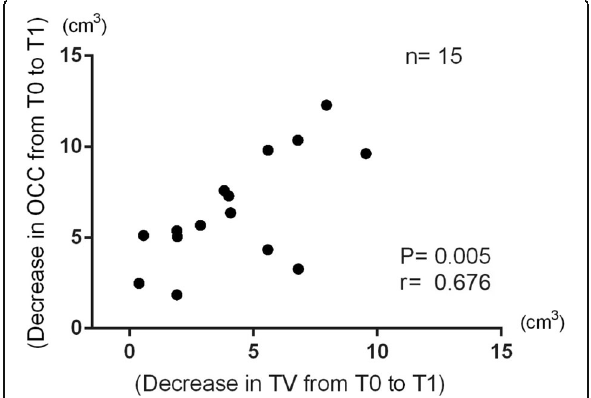
Fig. 6 The relation between the decrease in OCC and TV. The decrease in OCC showed a positive correlation with the decrease in TV from T0 to T1 after using the linear regression analysis ( P = 0.005, R =